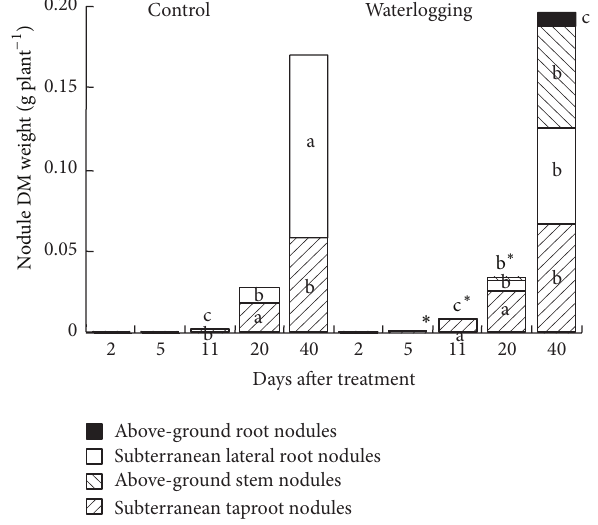
Figure 4: Changes in nodule DM weight in experiment 2. Symbols with different letters within the same investigation date and treat- ment show significant differences ( 𝑃 < 0.05 ). ∗ Significant difference ( 𝑃 < 0.05 ) in the total nodule DM weight at the same day.